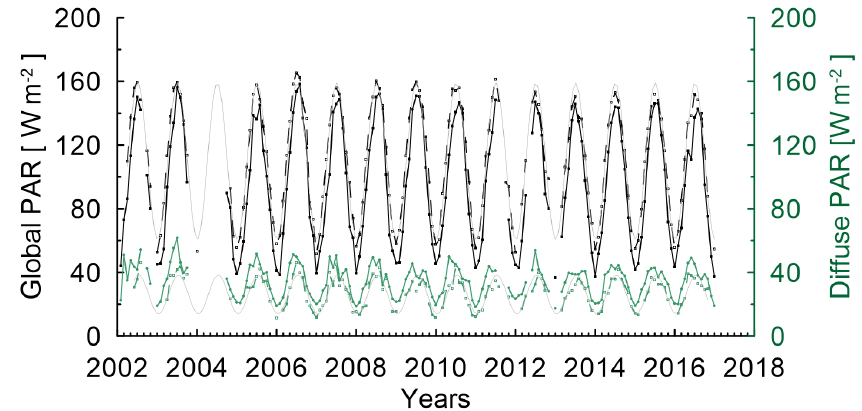
Figure 2. Time series of monthly mean global (black lines) and diffuse (green lines) PAR for cloud-free (dashed lines) and all-sky conditions (continuous lines). Fitting curves (see text) are shown by thin lines for the cloud-free time series.